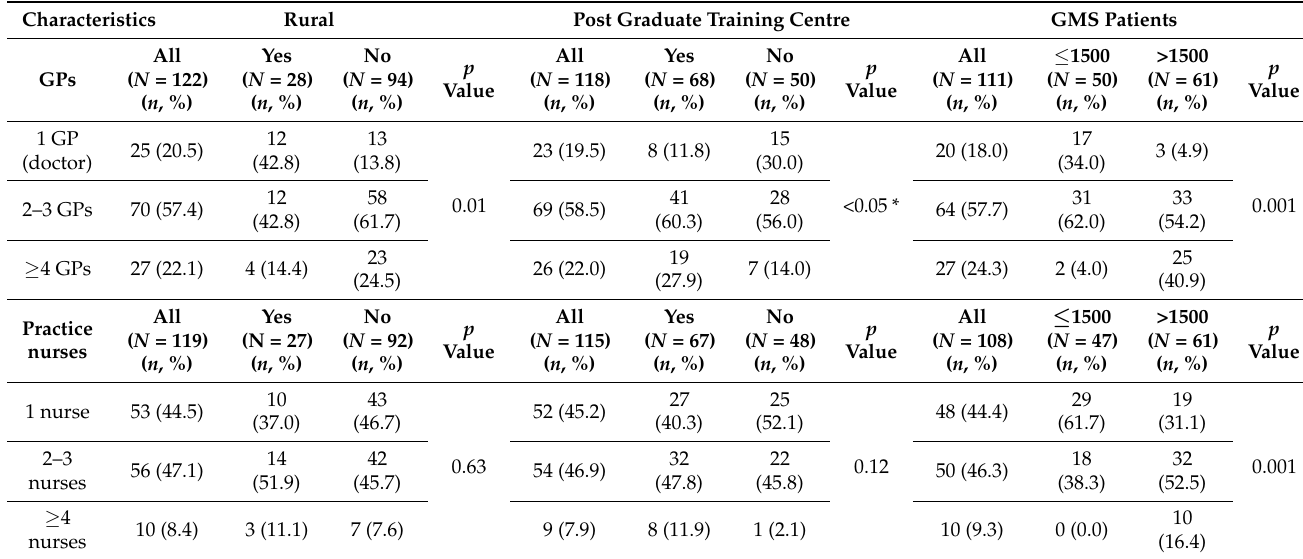
Table 1. Practice staff (GP and nurses) involvement in the CDM by practice location, size, and post-graduate training roles.